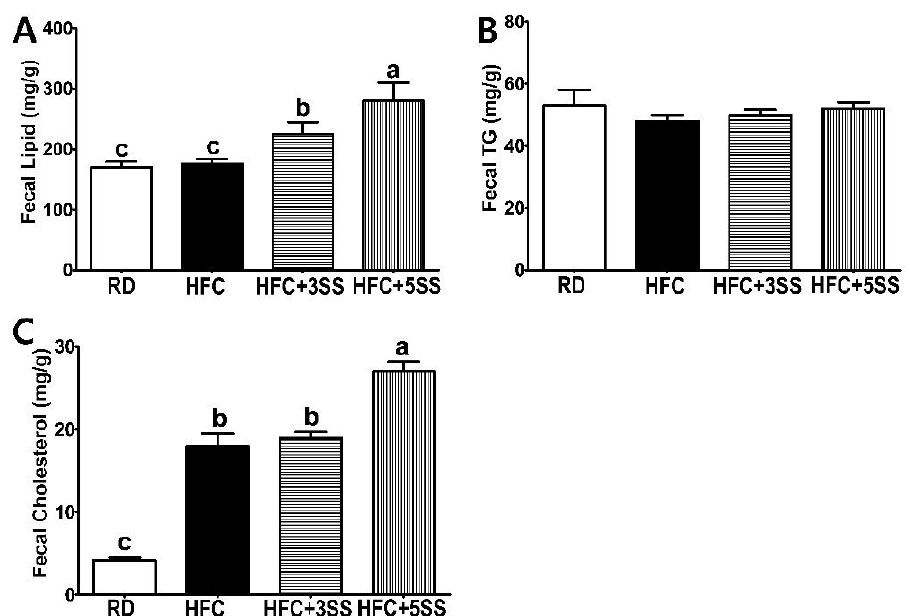
Figure 8. Effect of S. sieboldii Miq. root powder (SS) in fecal lipid excretion. Experimental rats were fed a regular diet (RD) or a high-fat and high-cholesterol (HFC) diet with or with-out Stachys sieboldii Miq. root powder (SS; 3 or 5%) supplementation for 6 weeks. ( A ) Fecal lipid, ( B ) fecal triglyceride (TG) and ( C ) fecal cholesterol were measured and expressed as mg/g. RD, regular diet; HFC, high-fat and high-cholesterol diet; HFC + 3SS, High-fat and high-cholesterol diet + 3% of Stachys sieboldii Miq. root powder; HFC + 5SS, high-fat and high-cholesterol diet + 5% of Stachys sieboldii Miq. root